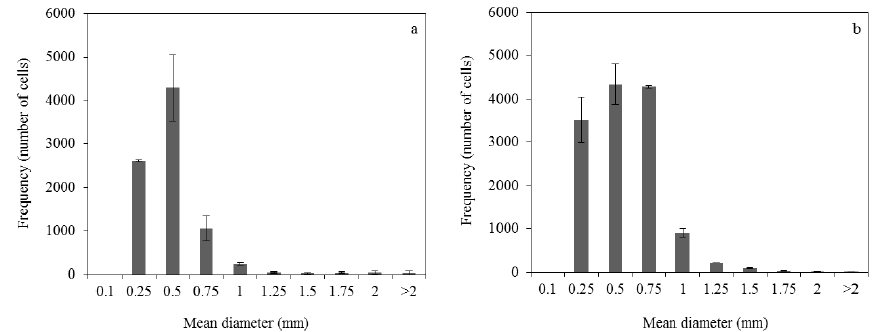
Figure 2. Pellet diameter distribution at 48 h of submerged fermentation of R. arrhizus NRRL 2582 using 25 g/L initial glucose concentration. The initial ammonium sulphate concentration was ( a ) 0.04 g/L and ( b ) 0.2 g/L.